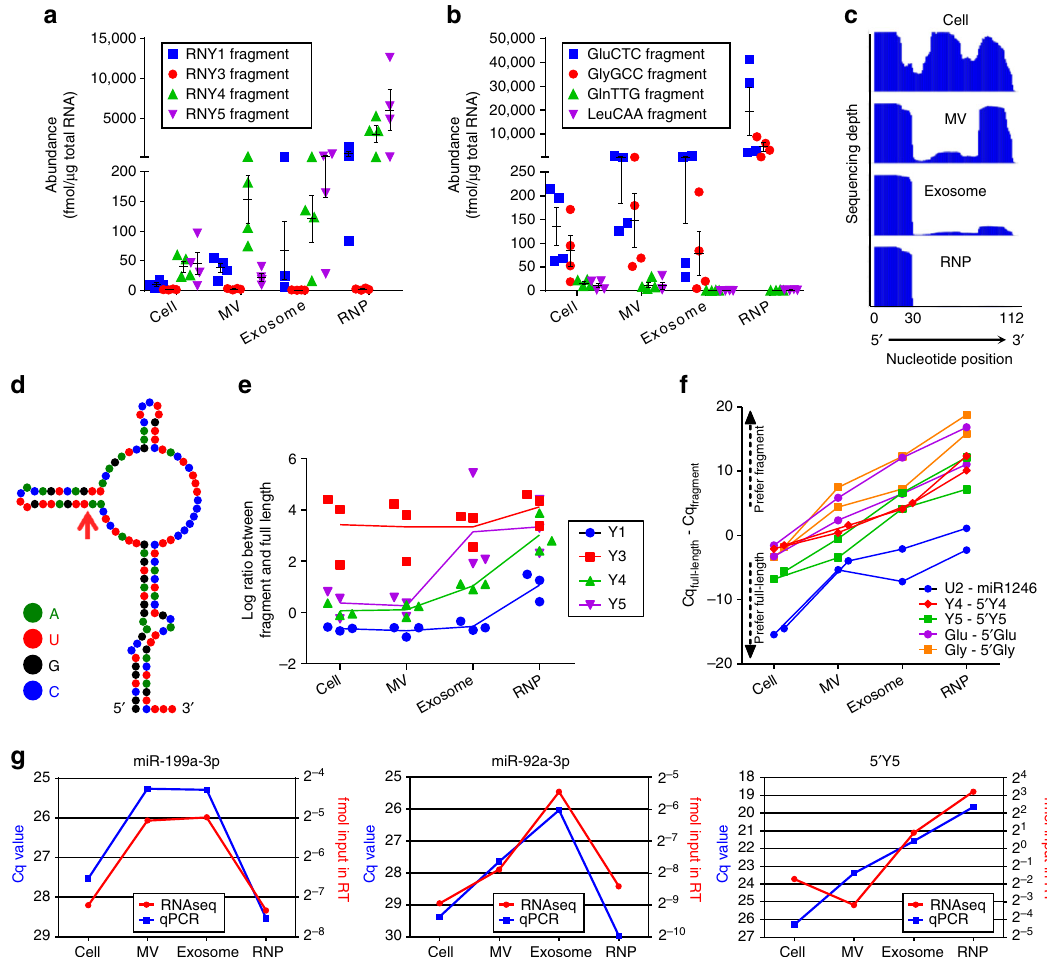
Fig. 6 Y RNA and tRNA fragments are abundant and enriched in exRNA. a , b Speci fi c Y RNA and tRNA species are among the most abundant in small RNA libraries ( n = 4 GSC cultures). The reads corresponding to Y1, Y4, and Y5 are highly enriched in extracellular fractions, especially in RNP ( a ). The reads corresponding to speci fi c tRNAs, such as GluCTC and GlyGCC, are highly enriched in exRNA, while others (e.g. GlnTTG and LeuCAA) are not ( b ). c Mapping coverage of Y1 reads indicates that the Y1 is precisely processed, and mostly its 5 ′ fragment is present in exosomes and RNPs, as evidenced by the steep peaks corresponding to the 5 ′ -end 30 nt. These pro fi les are distinct from the more uniform full-length coverage observed for the cellular RNA, and to a lesser extent MV RNA. Similar analysis for other Y RNAs and tRNAs is presented in Supplementary Fig. 12. d The predicted secondary structure of Y1 RNA 30 , Copyright (1993) National Academy of Sciences, USA, and the position of its cleavage (indicated by the arrow) that produces the 5 ′ fragment which is highly abundant in exRNA. e Quanti fi cation of Y RNA reads in long and small RNA libraries, demonstrates different fragment to full-length ratios in the cell and exRNA fractions ( n = 3 GSC cultures; MGG75 was excluded due to very low abundance of the full-length Y RNA). The ratios are increased in extracellular fractions. f qRT-PCR analysis with primers speci fi c to either full-lengths or fragments of several RNA species validates the enrichment of 5 ′ tRNA and Y RNA fragments in extracellular fractions. For each speci fi c transcript examined, two lines represent GBM8 and 20/3 cells, respectively. g qRT- PCR analysis of selected transcripts con fi rms the quantitative character of the RNAseq pipeline. The blue dots represent qRT-PCR Cq values, while the red dots represent the results of RNAseq quanti fi cation in fmol. Both analyses were performed on the same set of RNA samples. Error bars represent mean ±